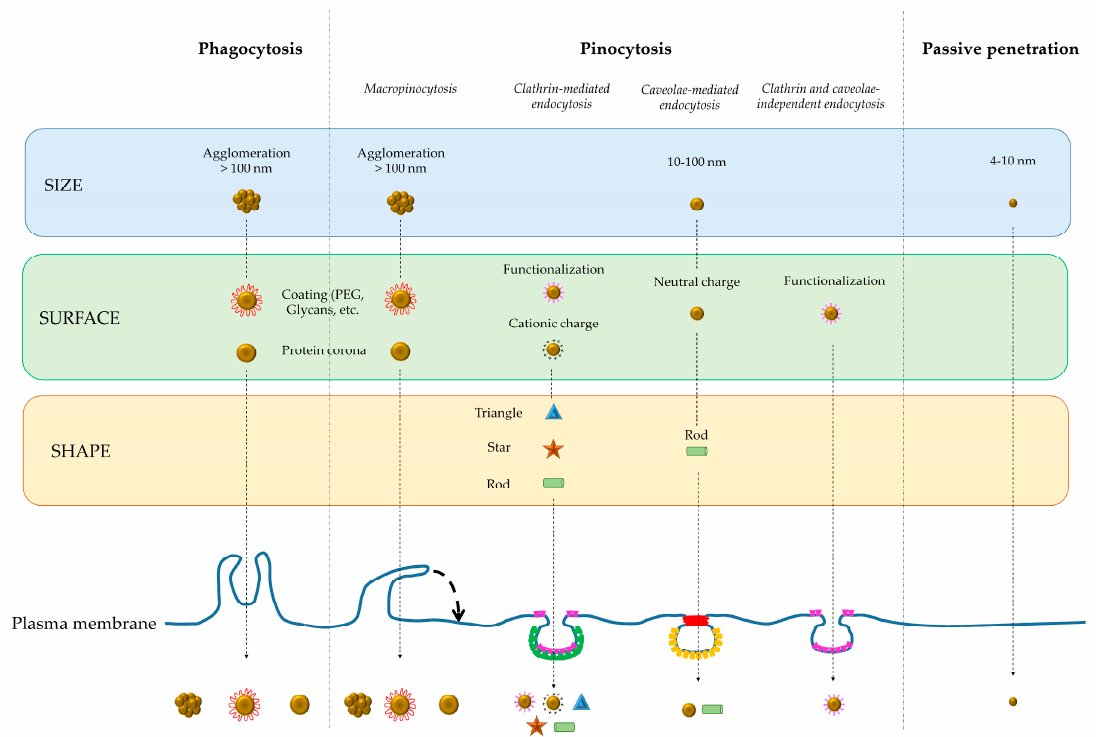
Figure 1. Internalization pathways of different types of nanoparticles. The cells can exploit different internalization mechanisms in relation to the nanoparticle properties, such as size, surface and shape. The cell can internalize the NPs by using different mechanisms also considering the same parameter.